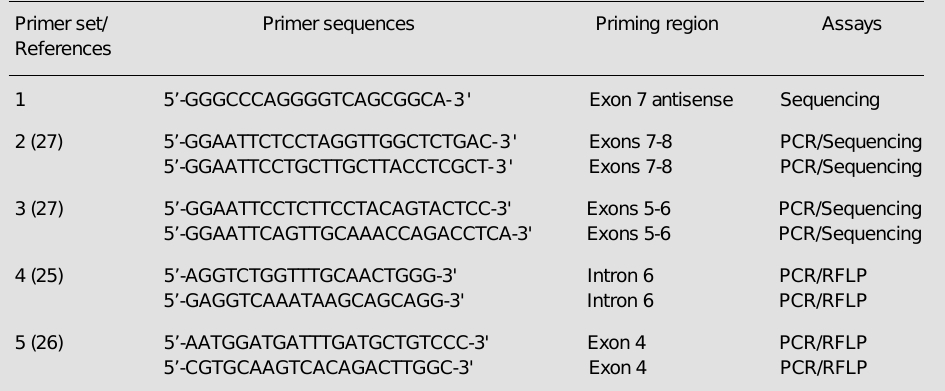
Table 2 - Primer sets used in PCR, sequencing and PCR-RFLP. Primer